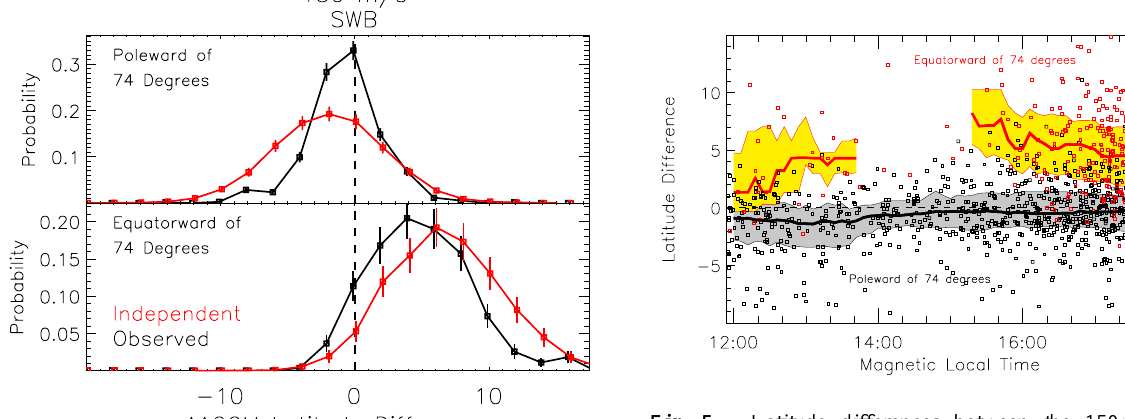
Fig. 5. Latitude differences between the 150m/s threshold SWB and the doc PPB measured in the afternoon sector (12:00– 18:00 MLT). The black symbols represent the difference values at the times when the SWB was identified poleward of 74 ◦ . The red symbols represent the difference values at the times when the SWB was identified equatorward of 74 ◦ . The dashed horizontal line at zero difference represents the location of the SWB. The bold black line and shaded grey area represent the spatial variation of the median and quartile range, respectively, of the latitude differences measured poleward of 74 ◦ . The bold red line and shaded yellow area represent the spatial variation of the median and quartile range, respectively, of the latitude differences measured equatorward of 74 ◦